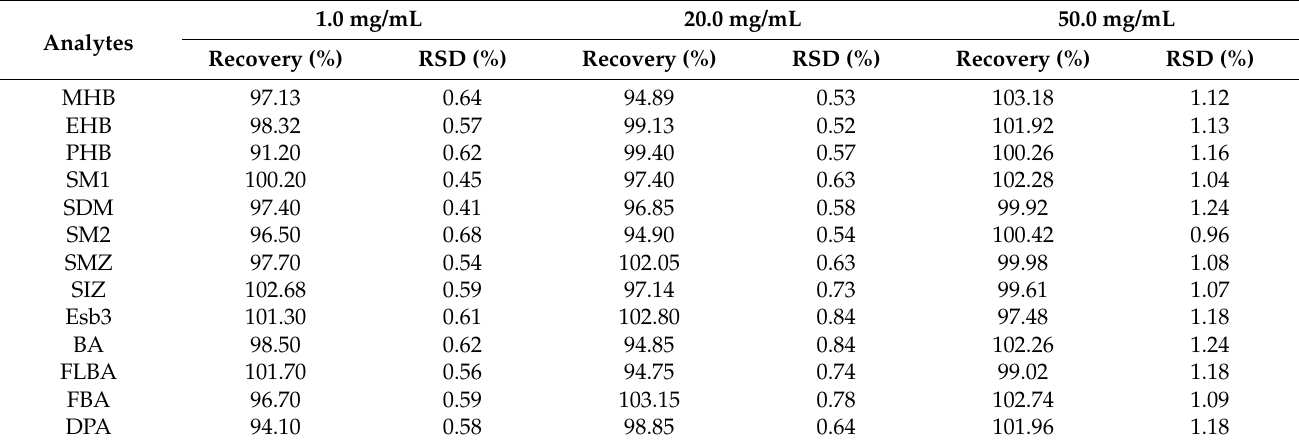
Table 5. Recoveries and RSDs for the small molecular compounds investigated ( n = 5).